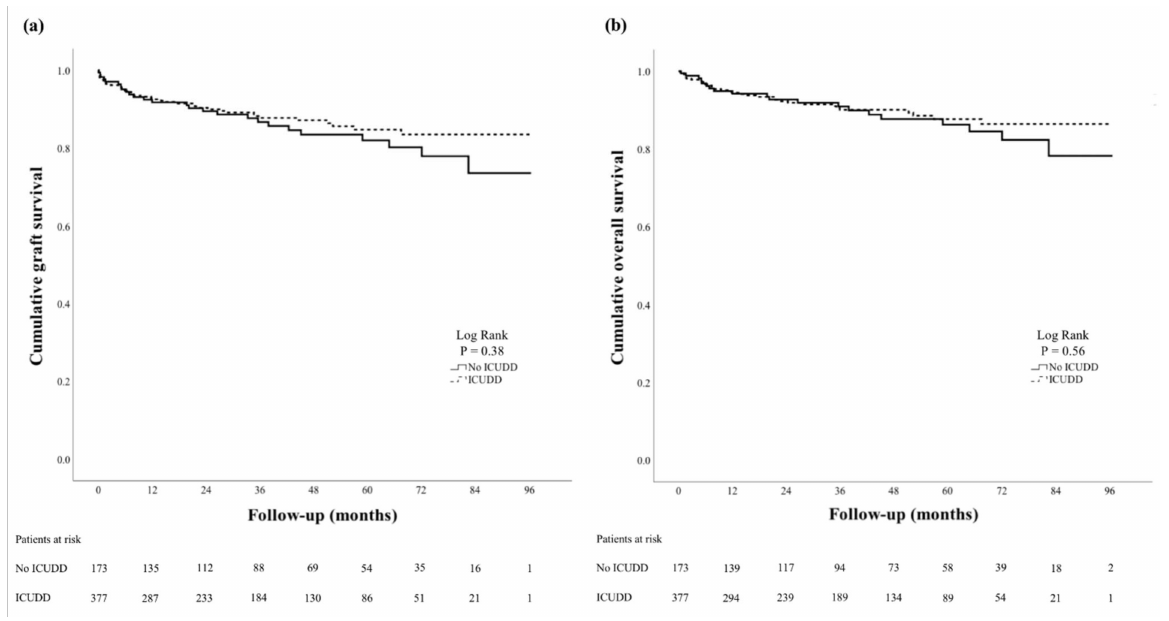
Figure 1. Survival analyses. Kaplan–Meier analyses of cumulative liver graft survival ( a ) and overall survival ( b ) in patients with no intensive care unit discharge delay (ICUDD) and patients with ICUDD.